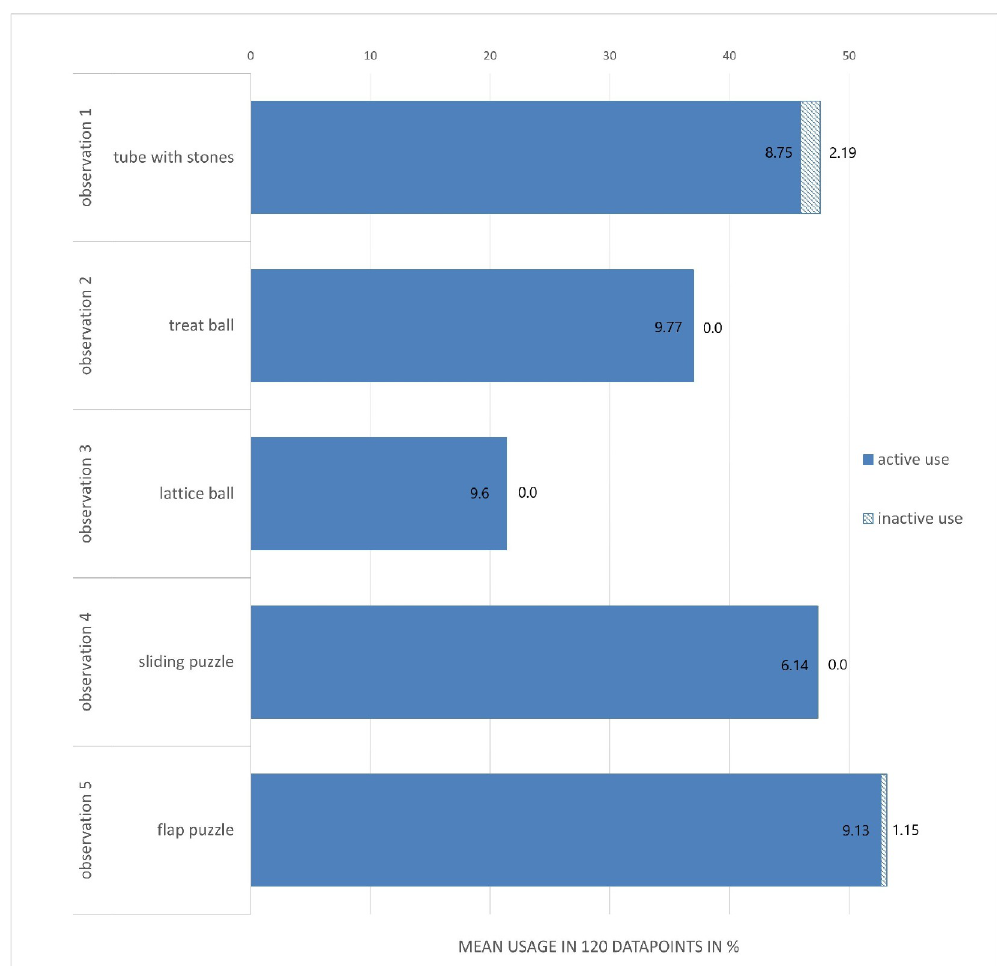
Fig 8. Video analysis of the active and inactive use of the foraging enrichments in 5 observations of mice in enriched housing conditions (12 mice in 3 groups of 4 per cage) given as mean % of 120 datapoints. Foraging enrichments were filled with millet during the observation period. Solid parts of the bars depict the active use of the respective elements and dashed parts of the bars depict the inactive use. Standard deviations for each stagged bar are given as numbers (inside bar for active use, outside for inactive